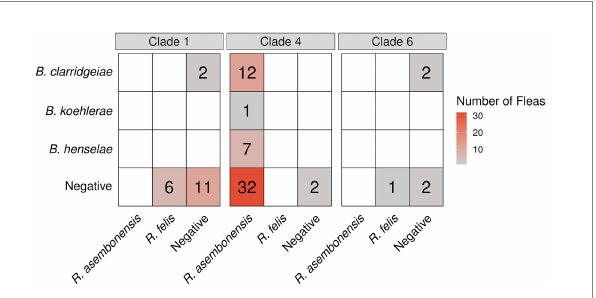
FIGURE 7 Heatmap displaying the Bartonella ( y -axis) and Rickettsia ( x -axis) coinfection status by Ctenocephalides felis